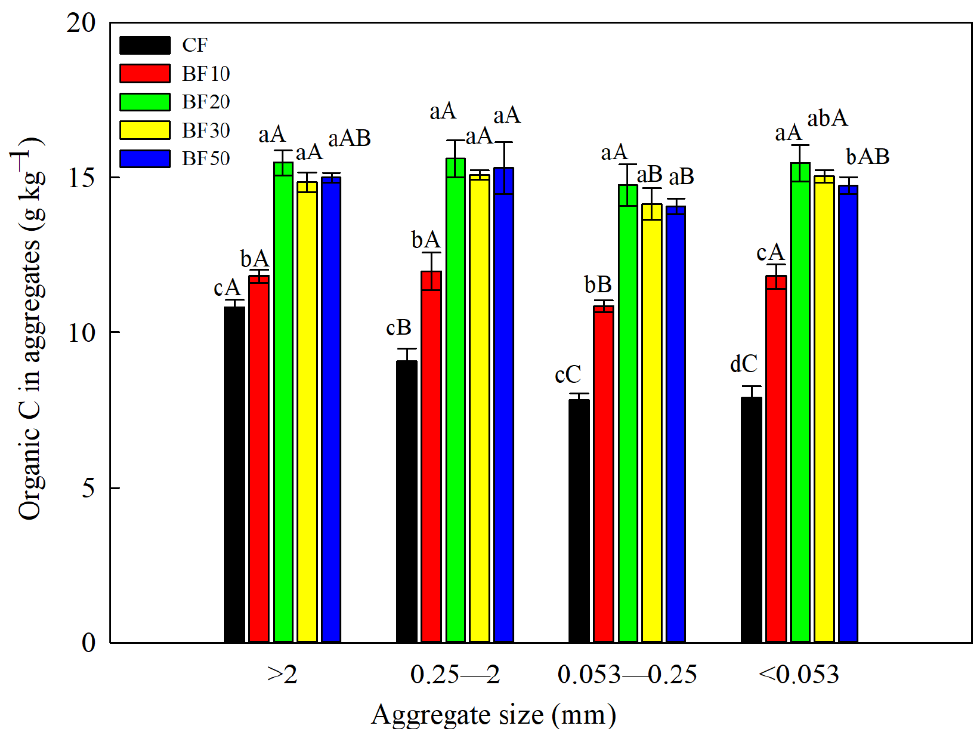
Figure 1. Organic C in different aggregate classes in the five treatments. Different lowercase letters indicate significant differences between treatments, and different uppercase letters indicate differences between aggregate size classes at p < 0.05. Error bars represent standard deviation of means ( n = 3). CF: 100% chemical fertilizer N; BF10: chemical fertilizer N supplemented with 10% bio-fertilizer N; BF20: chemical fertilizer N supplemented with 20% bio-fertilizer N; BF30: chemical fertilizer N supplemented with 30% bio-fertilizer N; BF50: chemical fertilizer N supplemented with 50% bio-fertilizer